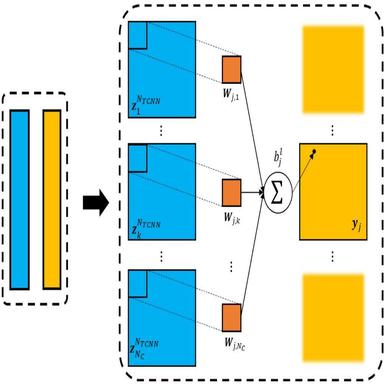
Additional convolutional neural network in RVE-net for checkerboard problem of TCNN.